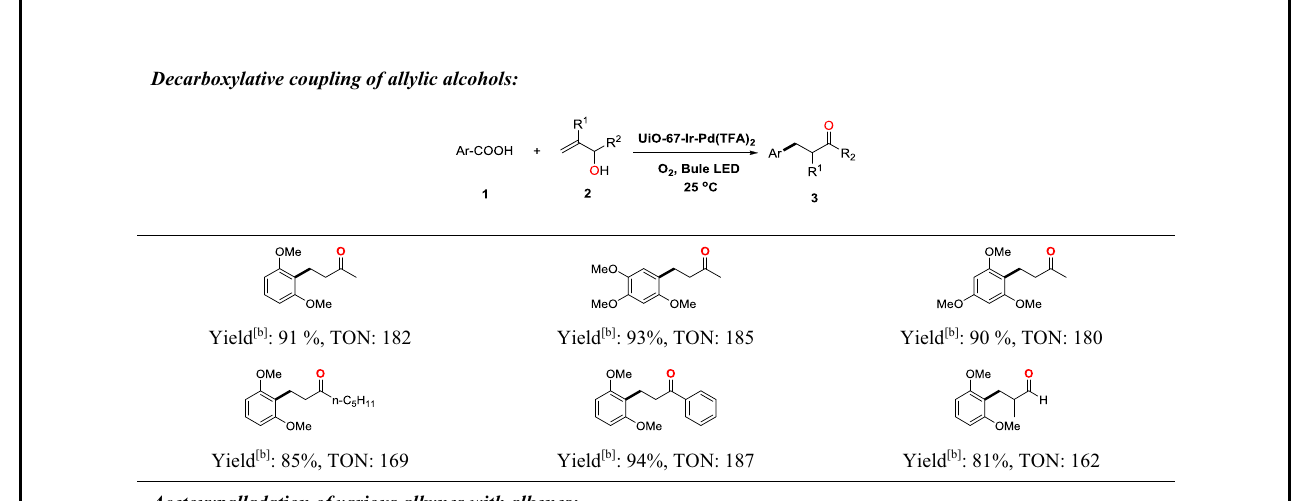
Table 2 Substrate scope of representative oxidation reactions catalyzed by UiO-67-Ir-Pd X 2 a .